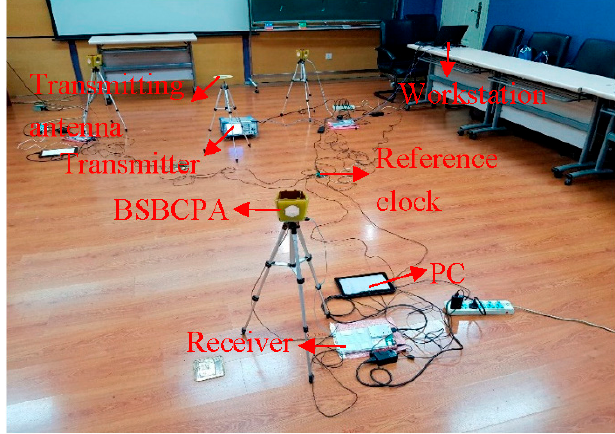
Figure 7. Photo of positioning equipment and venue in conference room.